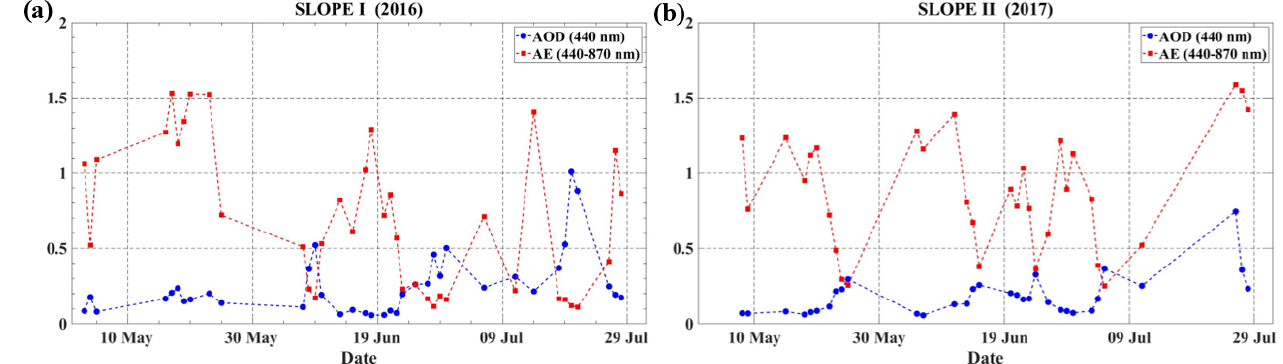
Figure 6. Temporal evolution of aerosol optical depth (AOD) at 440nm and Ångström exponent (440–870nm) retrieved by GRASP during the (a) SLOPE I and (b) SLOPE II campaigns.